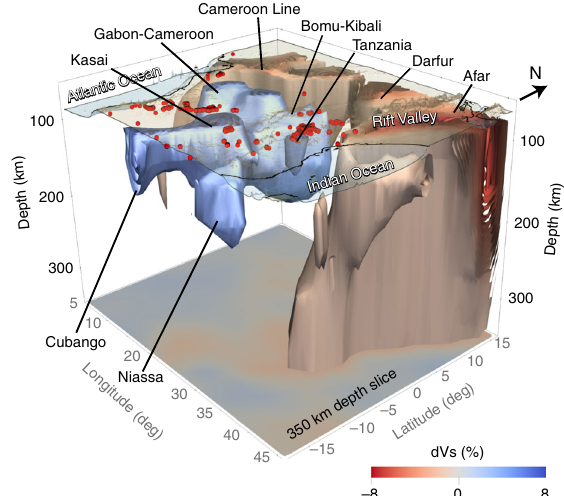
Fig. 4 Three-dimensional view of hotspots and cratons in central-eastern Africa. High-velocity isosurfaces at + 5% and low-velocity ones at (cid:3) 1.5% are plotted in the 80 – 350 km depth range. The 350 km δ V S map view is plotted at the depth. Kimberlite and lamproite sample locations are shown as red